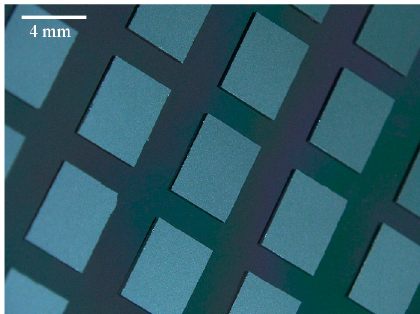
Figure 8. A photomicrograph of self-assembled chips directly bonded to a wafer through CMP-treated PE-CVD oxide.